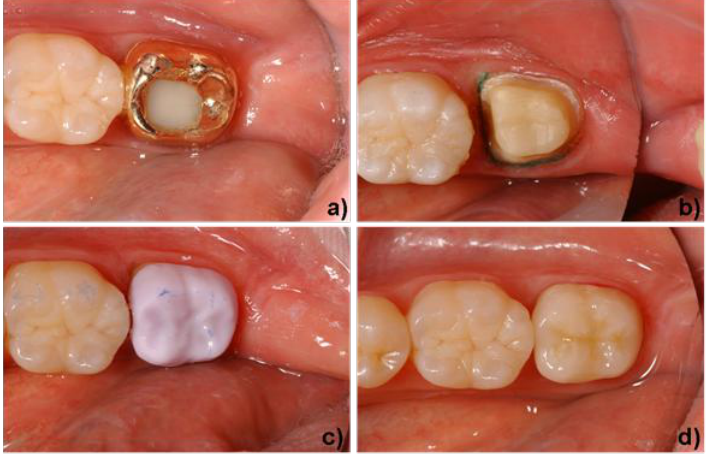
Figure 9. Application of a lithium disilicate-based glass-ceramic. a) initial situation (tooth #37), worn gold crown. b) preparation of the molar for a full contour crown (IPS e.max  CAD). c) try-in of a full contour crown in its lithium metasilicate state. d) final clinical situation after the crystallization step (stained and glazed) and adhesive cementation of the crown. Dentist: A. Peschke (Ivoclar Vivadent